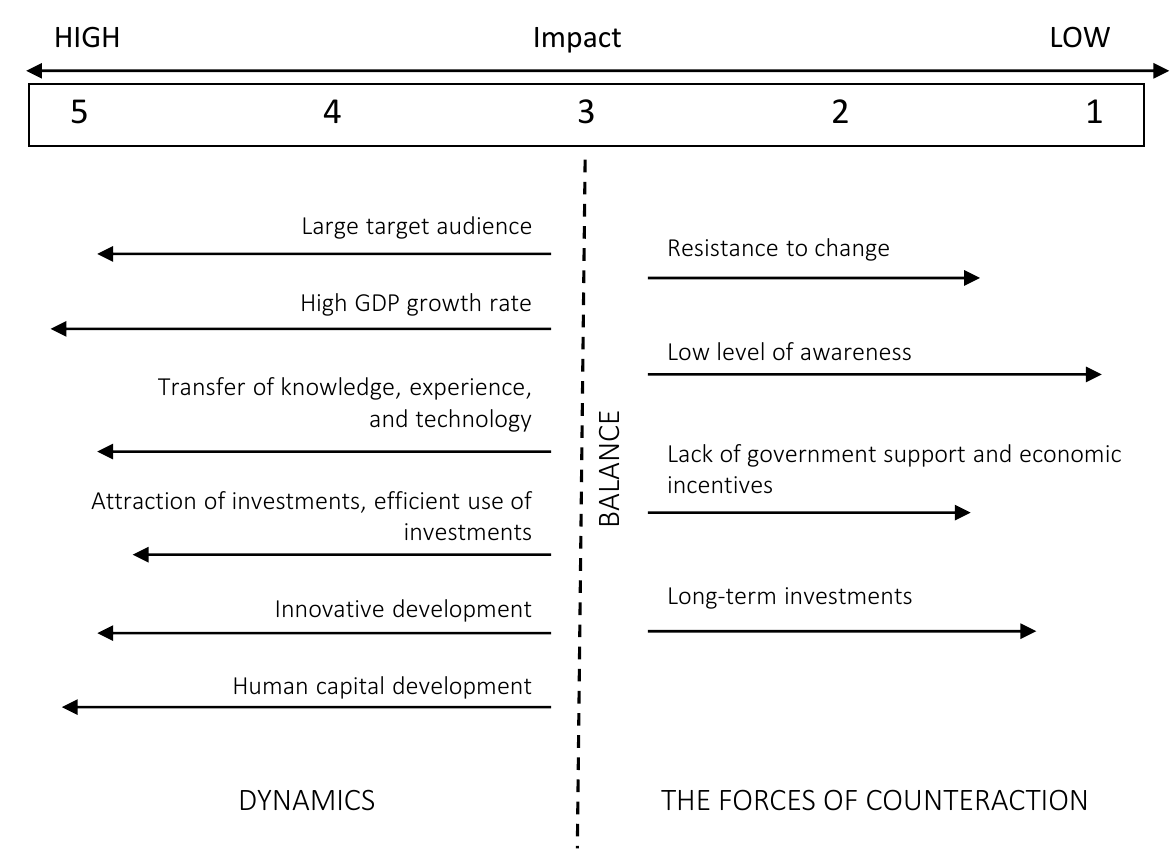
Figure 5. Force field of the EEN system in